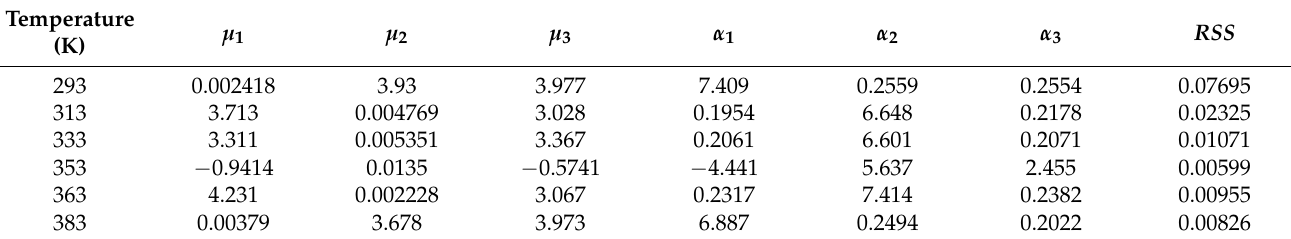
Table 2. Parameters fitting of the Ogden constitutive model ( N = 3) with the experimental data of the C20 rubber specimen at different temperatures.